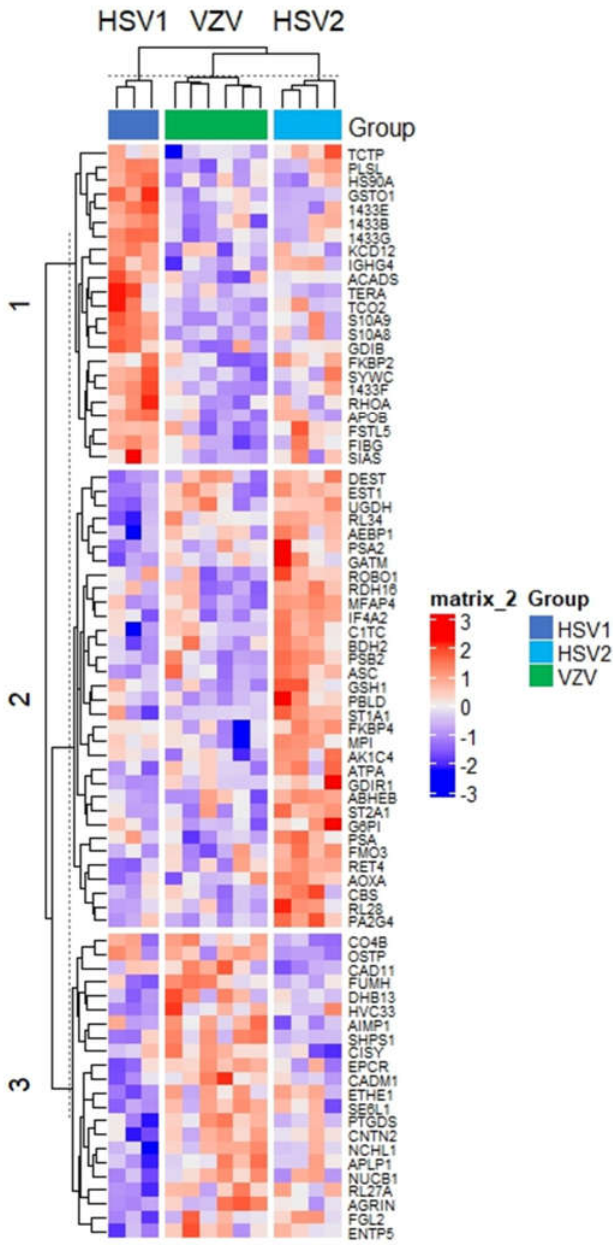
Figure 5. Hierarchical clustering of 78 ANOVA significant proteins comparing HSV-1, HSV-2, and VZV. Red indicates an increase in log2 intensity while blue indicates a decrease in log2 intensity.